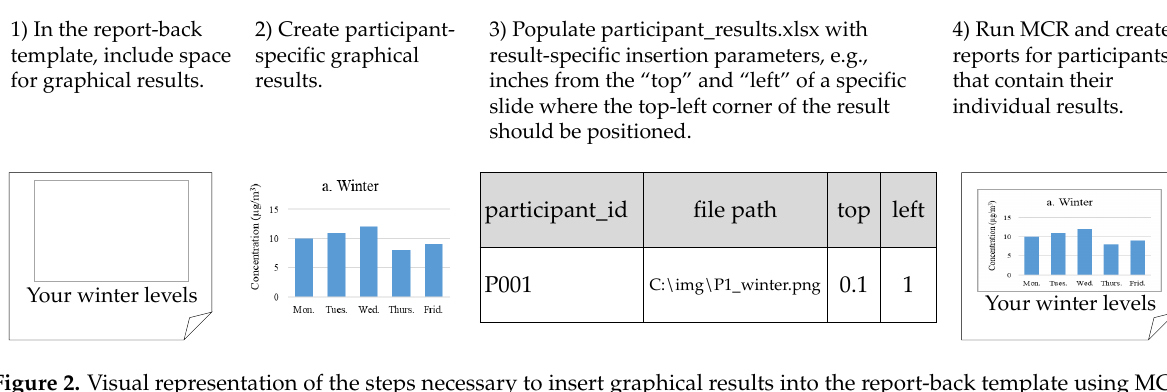
Figure 1. Visual representation of the steps necessary to insert numerical and text data into the report-back template using MCR.